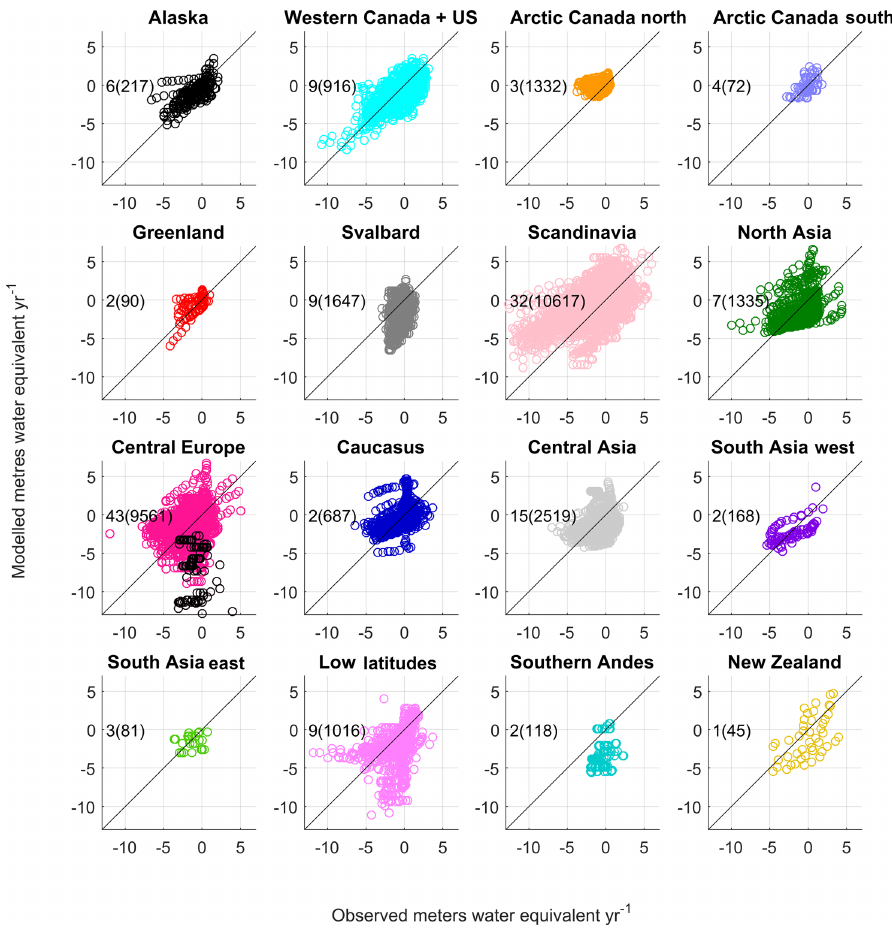
Figure 3. Modelled annual elevation-dependent specific mass balance against observations from the WGMS. The modelled mass balance is simulated on a 0.5 ◦ grid resolution at 250m elevation bands and the observations are for individual glaciers at elevation levels specific to each glacier. The observed mass balance is interpolated onto the JULES elevation bands. If only a single observation exists, then mass balance for the nearest JULES elevation band is used. The number of glaciers is shown in the top left-hand corner and the number of observation points in brackets. In central Europe mass balance for the Maladeta glacier in the Pyrenees is shown in black